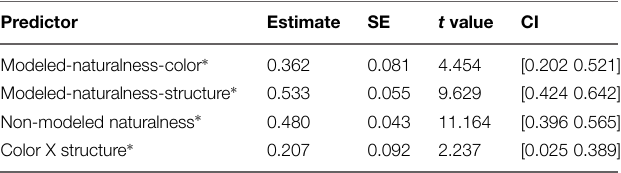
TABLE 5 | Results of regressing esthetic preference on color-related and structure-related bottom–up naturalness and non-modeled